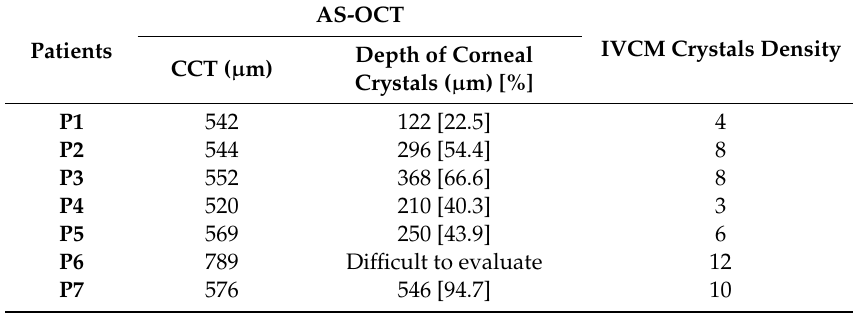
Table 4. Assessment of cystine crystals using anterior segment optical coherence tomography (AS-OCT) and in vivo confocal microscopy (IVCM).